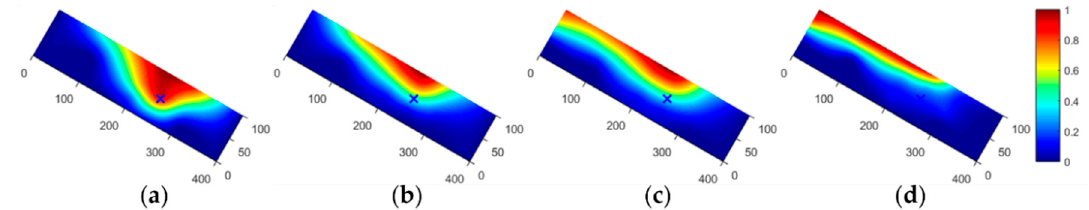
Figure 6. The gas distribution at different shut-in times of Exp1. ( a ) 24 h after shut-in; ( b ) 48 h after shut-in; ( c ) 72 h after shut-in; ( d ) 96 h after shut-in.